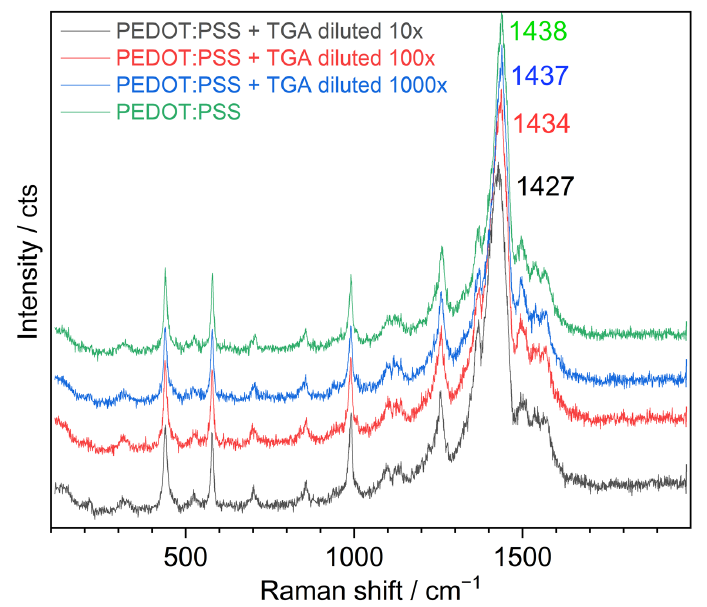
Figure 3. Control experiment showing the effect of pure TGA solution on the Raman spectra of